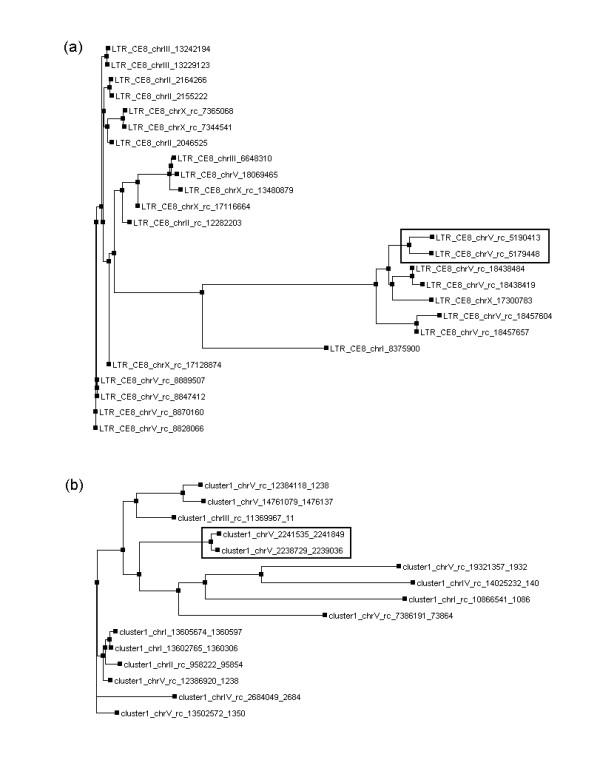
Phylogenetic trees of clusters LTR_CE8 (a) and LTR_CE15 (b) in C. elegans. The elements LTR_CE8_chrV_rc_5190413 and LTR_CE8_chrV_rc_5179448 in tree (a) and LTR_CE15_chrV_2241535 and LTR_CE15_chrV_2238729 in tree (b), highlighted in rectangular boxes, are intact LTR retroelements identified by phylogenetic analysis.